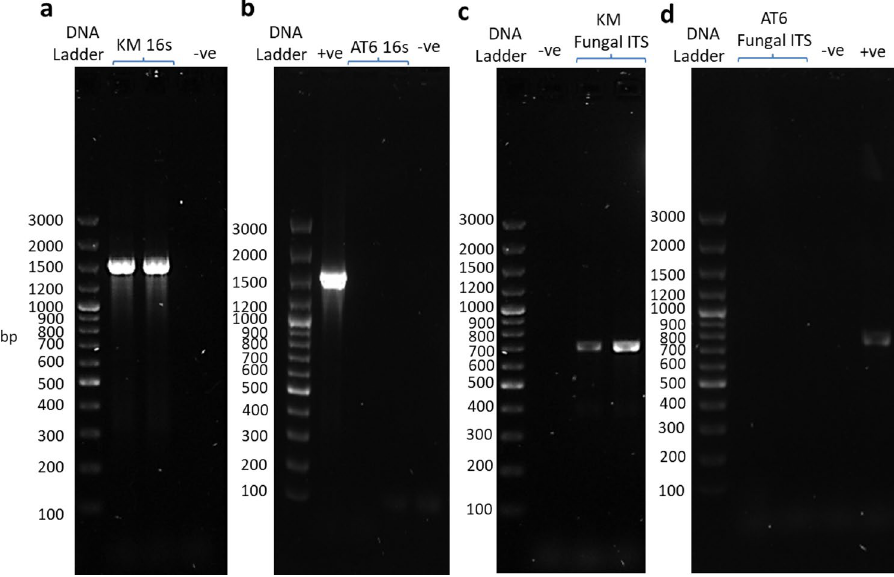
Figure 5. PCR amplification of bacterial 16 s rDNA for ( a ) KMHK and ( b ) AT6 samples and that of fungal ITS region for ( c ) KMHK and ( d ) AT6 samples obtained from basic protocol and serial dilution. +ve: positive control, -ve: negative